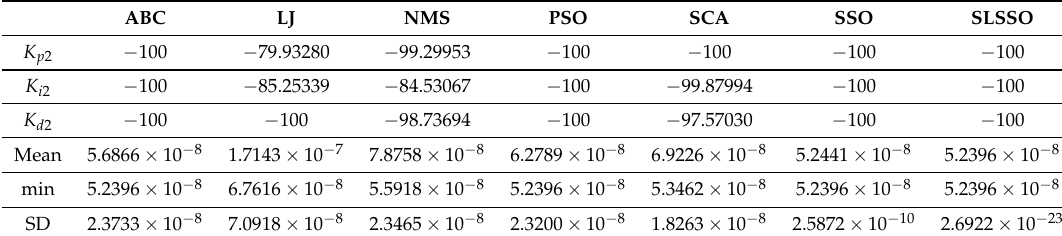
Table 6. Values of controller parameters for control loop II.